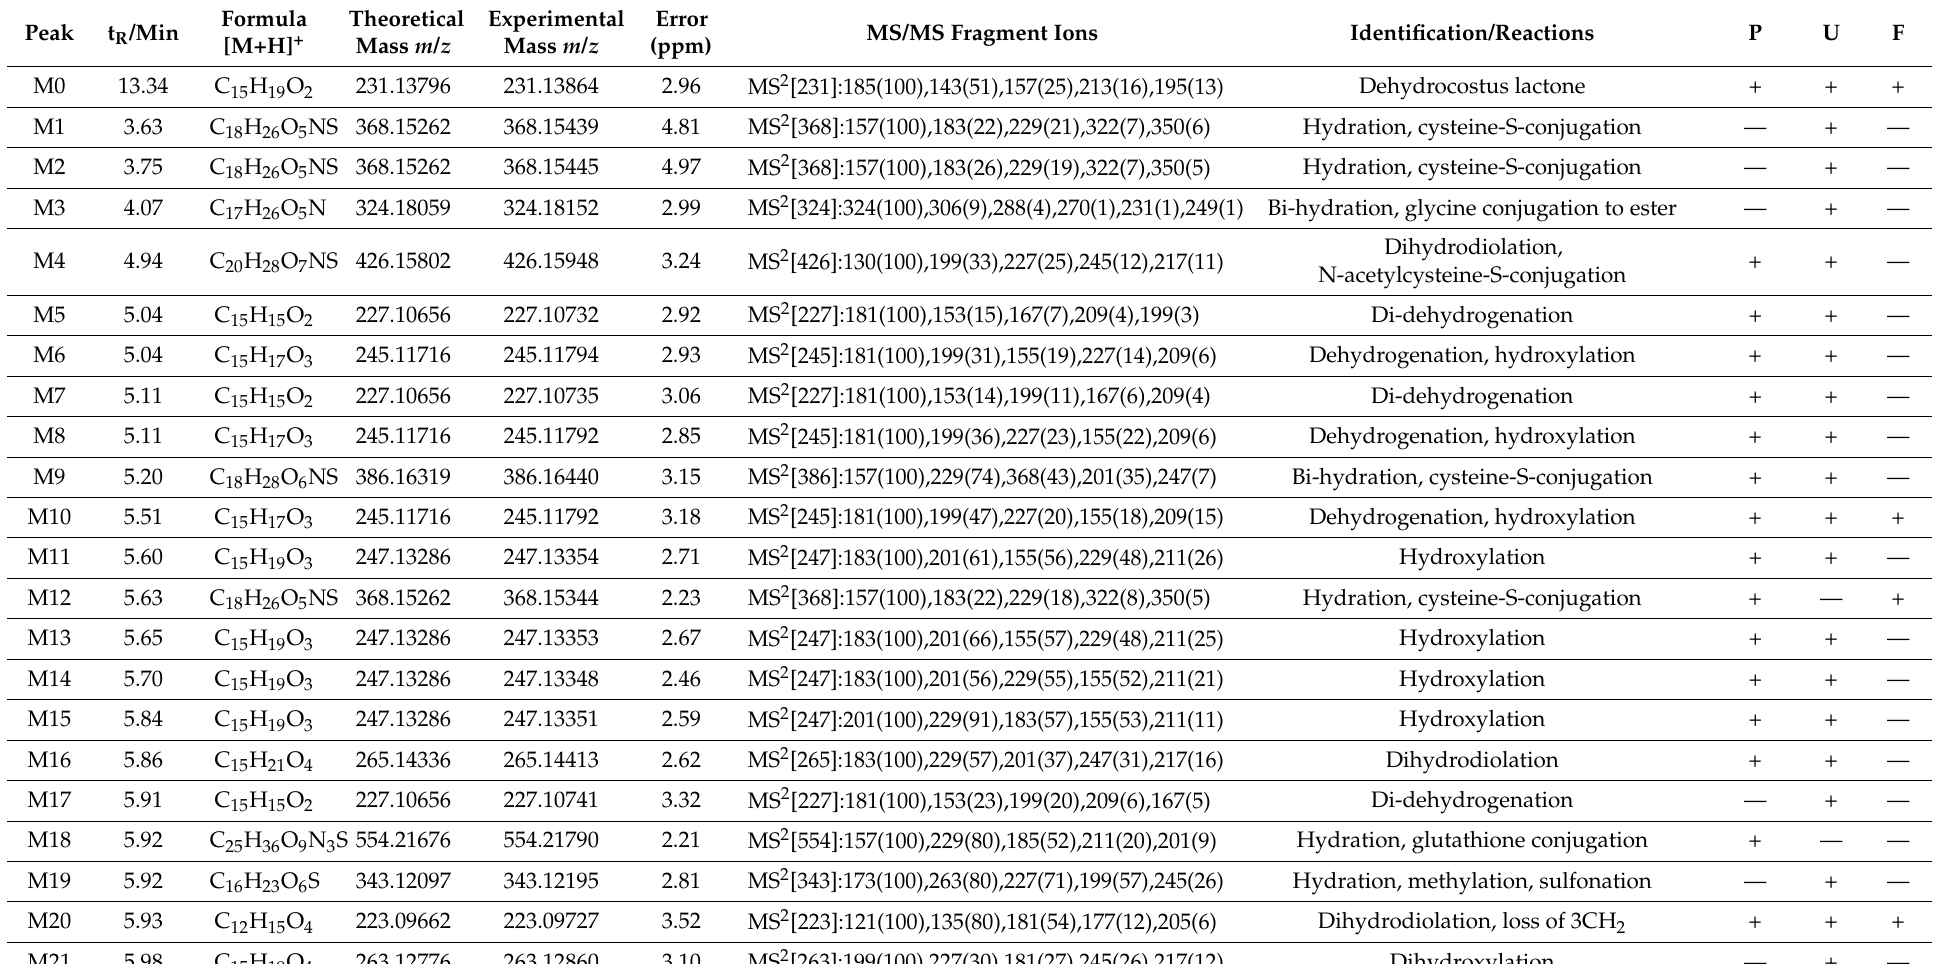
Table 2. Summary of DL metabolites in rat plasma, urine, and